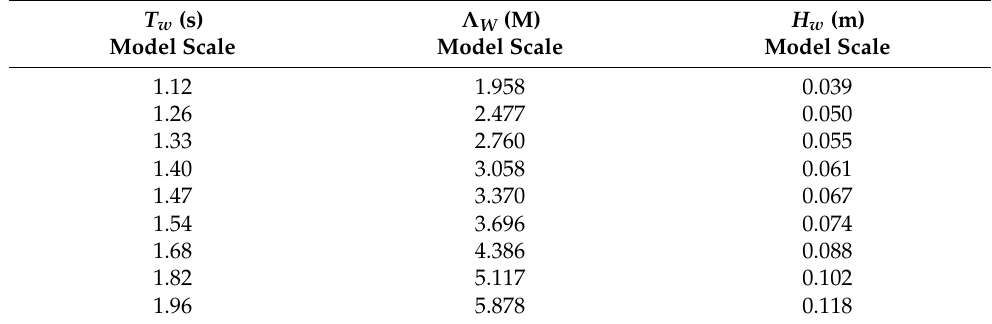
Table 2. The wave conditions used in the computation.